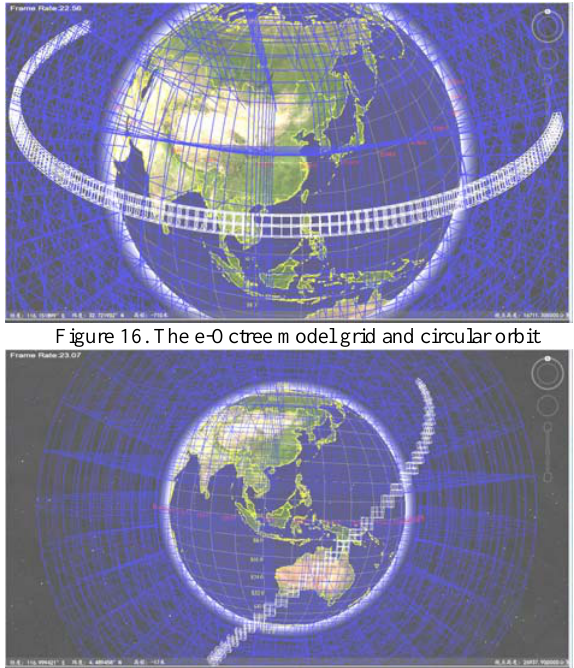
Figure 17. The e-Octree model grid and arbitrary orbit In the second experiments, the e-Octree model is used to represent the orbit of different satellites and the position change during movement. These grid frame cells, position code are all generated real time. The rendering efficiency is stably near 40 fps during the whole test.